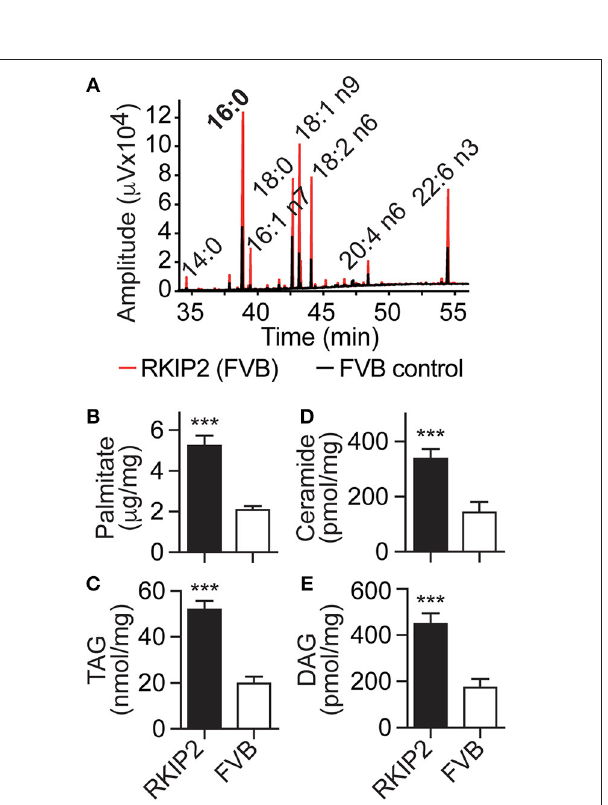
FIGURE 7 | FVB control mice ( ± s.d.; n = 5; *** p < 0.001 vs. FVB; Dunnett’s test). (F) Histological analysis of cardiac sections shows cardiac hypertrophy with dilatation in Tg-RKIP1 and Tg-RKIP2 hearts. (G) . Cardiomyocyte cross-sectional diameter (G) , systolic blood pressure (H) , and urinary albumin to creatinine ratio, ACR (I) in Tg-RKIP1, Tg-RKIP2, and non-transgenic FVB mice. (J) Increased body weight (left), lung weight (middle), and lung-to-body weight ratio (right) in Tg-RKIP1 and Tg-RKIP2 mice compared to non-transgenic FVB mice ( ± s.d.; n = 6; * p < 0.05; ** p < 0.01; *** p < 0.001 vs. FVB; Dunnett’s test). (K,L) 4 weeks of RKIP down-regulation by lentiviral transduction of an miRNA targeting RKIP by RNAi retards the development of cardiac dysfunction in 10-week-old (10w) Tg-RKIP2 mice (K) . Panel (L) documents the down-regulation of cardiac RKIP ( PEBP1 ) expression in miRKIP-transduced Tg-RKIP2 mice by qRT-PCR ( ± s.d.; n = 5; *** p < 0.001, ** p < 0.01, and * p < 0.05 vs. FVB; Dunnett’s test). See also Supplementary Figure 6 .